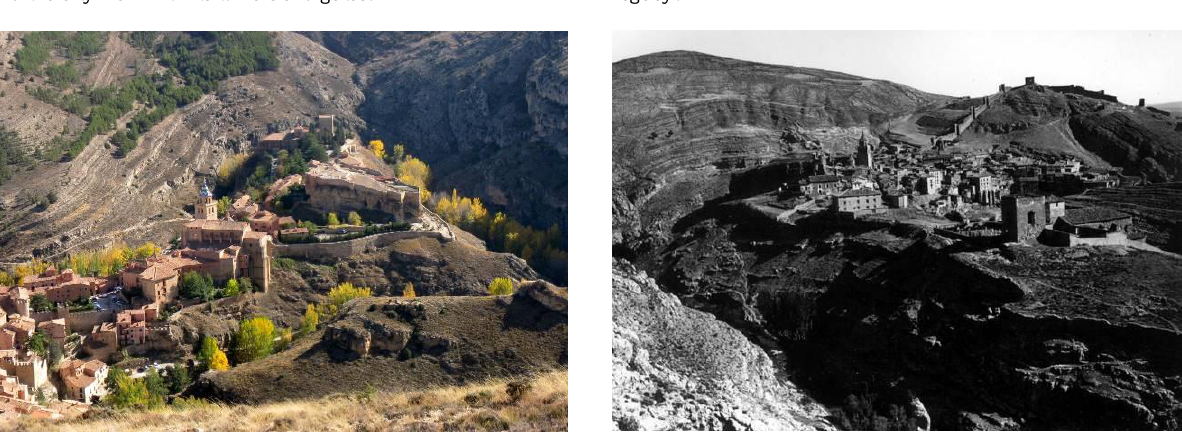
Figure 2. The city of Albarracín from the South (J. Díaz). Figure 3. The city of Albarracín from the North (Instituto de Estudios Turolense, Archivo López Segura, 147,